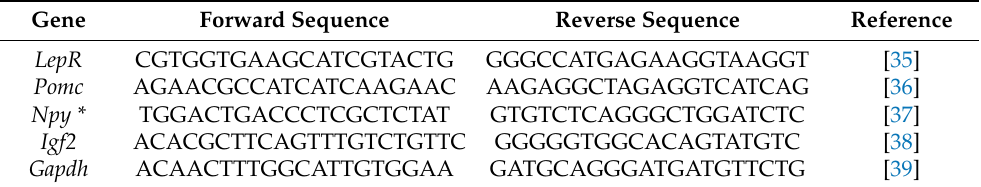
Table 2. Sequence of primers used in the gene expression analysis. Gene Forward Sequence Reverse Sequence Reference LepR